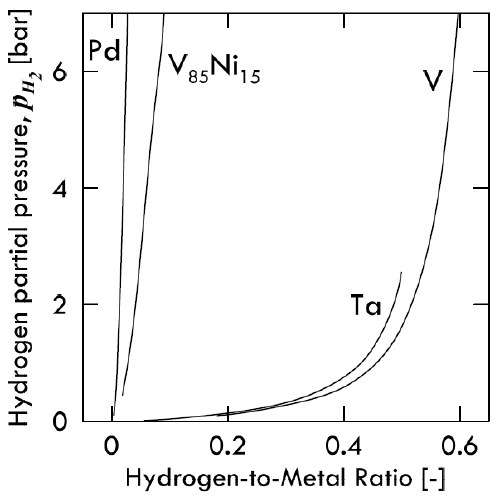
Figure 4. Isotherms for selected metals and alloys measured using Sieverts’ technique, in which the metal sample is equilibrated in a hydrogen atmosphere. The test for Pd are carried out at 340 °C, whereas for all the others metals a temperature of 400 °C is used. Adapted from Dolan [11].